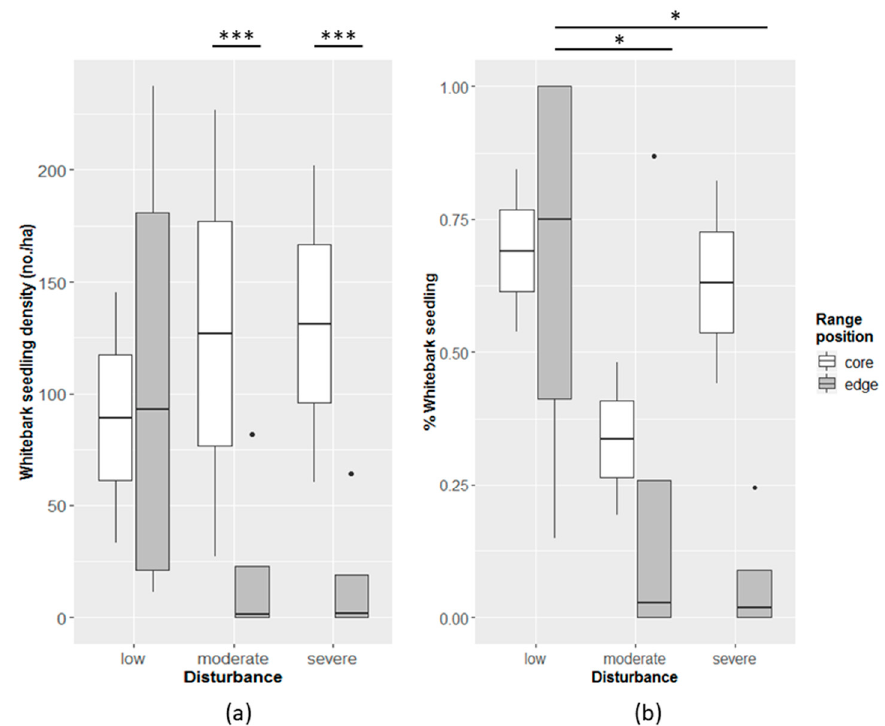
Figure 7. Box and whisker plots illustrating Study #2 GLMM results for ( a ) whitebark pine seedling density; and ( b ) % whitebark pine seedlings of total seedling numbers. Multiple comparisons between groups using Tukey’s method are shown only for comparisons of primary interest (*** α = 0.001 and * α = 0.1).